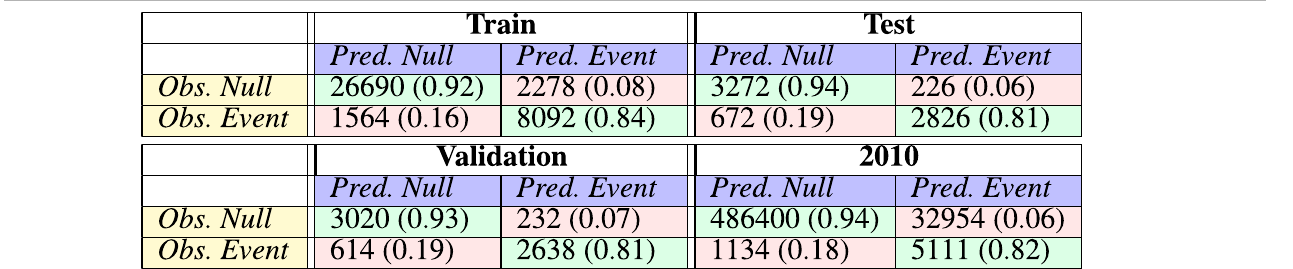
Frontiers in Astronomy and Space Sciences |